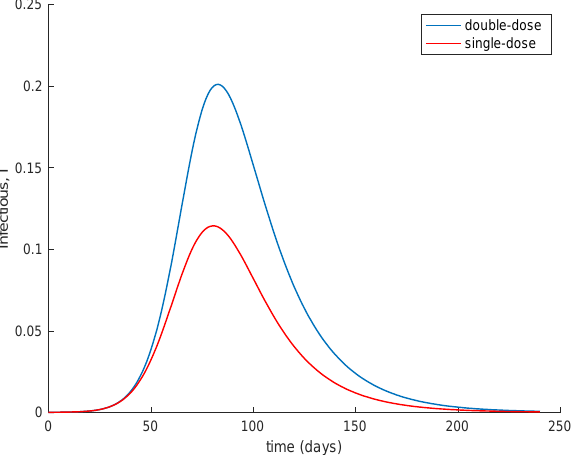
Figure 8. Comparison in the evolution of the number of infectious between the administration of a double dose ( K = 0.01 ) or a single dose to a broader population ( K = 0.02 ).